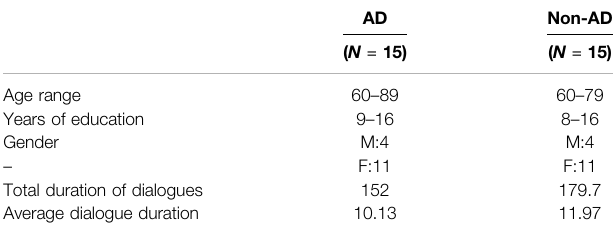
TABLE 1 | Demographic data for AD and non-AD patients, with dialogue duration in minutes.